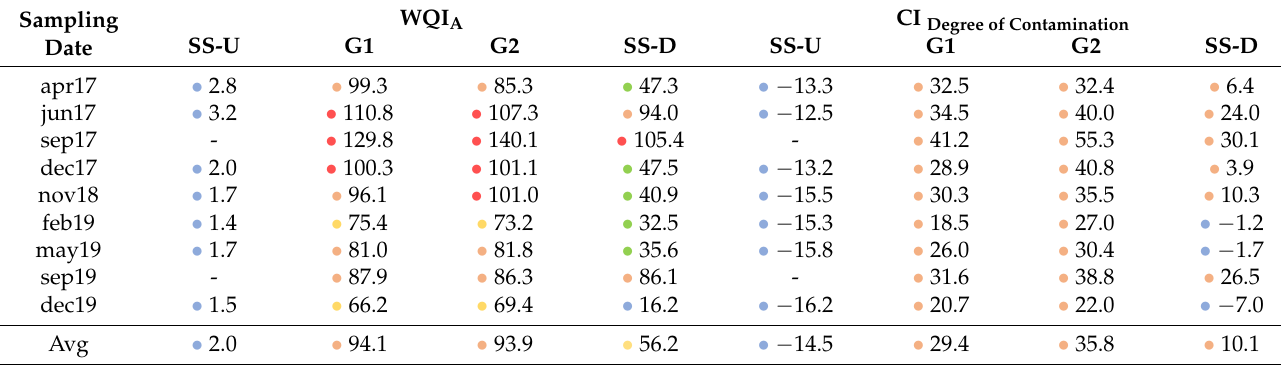
Table 4. Calculated values of WQI A (Water Quality Status) and CI (Level of